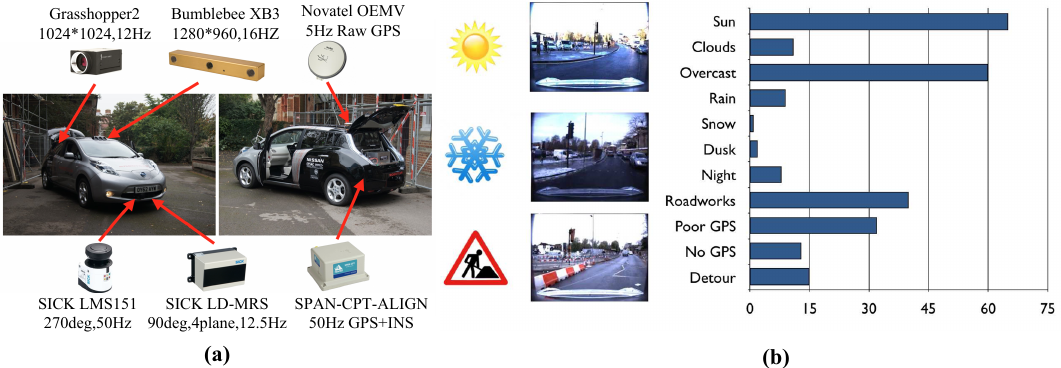
Figure 5. ( a ) shows the Oxford RobotCar platform with the equipped sensors, and ( b ) indicates the recording data sequences number in different conditions